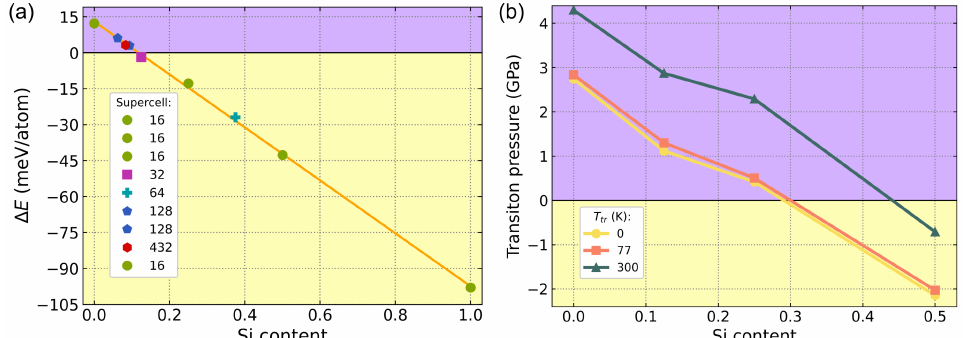
Figure 11. ( a ) Energy difference between the LMS and HMS as a function of the Si content for Mn 2 VGe 1 − x Si x alloys. Various compositions are simulated by generating SQS supercells with different numbers of atoms. The orange line gives the linear approximation. ( b ) Transition pres- sure for switching between the LMS and HMS as a function of the Si content. Figure adapted from Ref. [64].